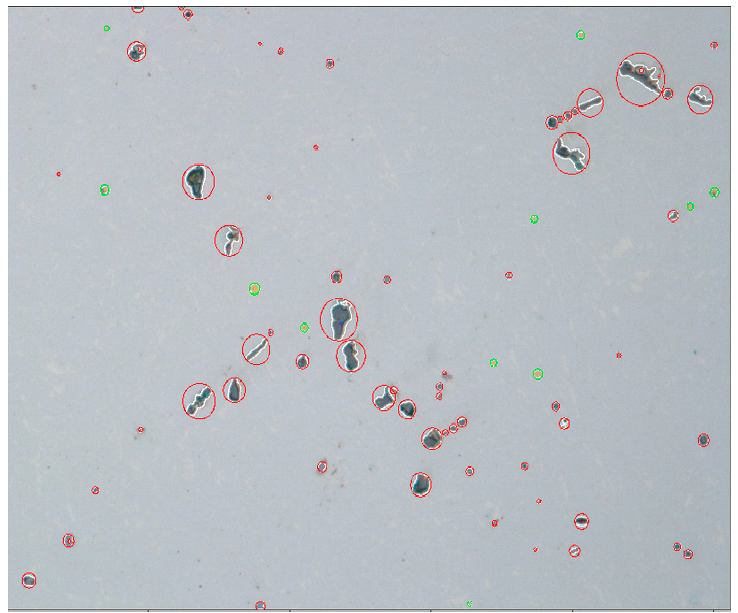
Figure 4. View of the macrostructure of 42CrMo4 steel with the types of inclusions marked: red colour—oxides, green colour—sulphides (total dimension of the analysis area 20 mm 2 ; magnitude 200 × ).